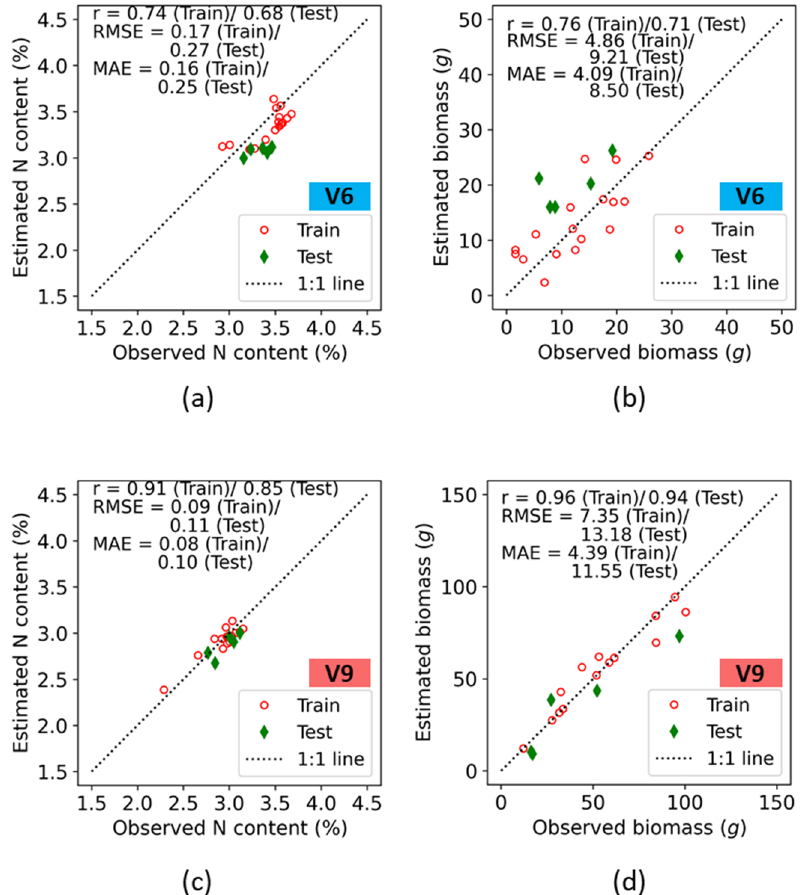
Figure 8. Training and test accuracies of crop N indicators retrieval using fluorescence indices at the V6 ( a , b ), and V9 ( c , d ) growth stages of maize at the Iliff site. Crop parameter estimates at the V9 growth stage indicated higher values of r as com- pared with V6 growth stage. The r values across the two crop parameters were